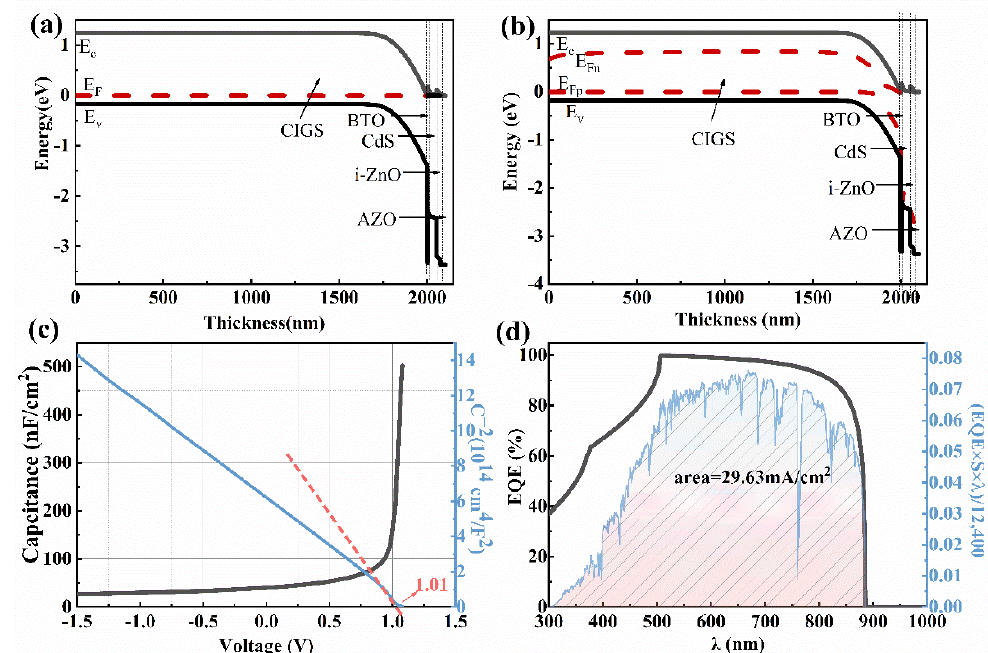
Figure 8. The energy band diagram, C - V , and EQE curves of the ferroelectric-coupled CIGS solar cell with a device structure of Mo/CIGS/ BTO/CdS/i-ZnO/AZO and a CIGS bandgap of 1.40 eV: ( a ) under non-light conditions, ( b ) under the AM1.5 G, 1SUN, 1000 W/m 2 condition, ( c ) C - V curve and C −2 - V curve, ( d ) EQE curve and the J sc value from the integral curve based on the expression EQE × S × λ 12,400